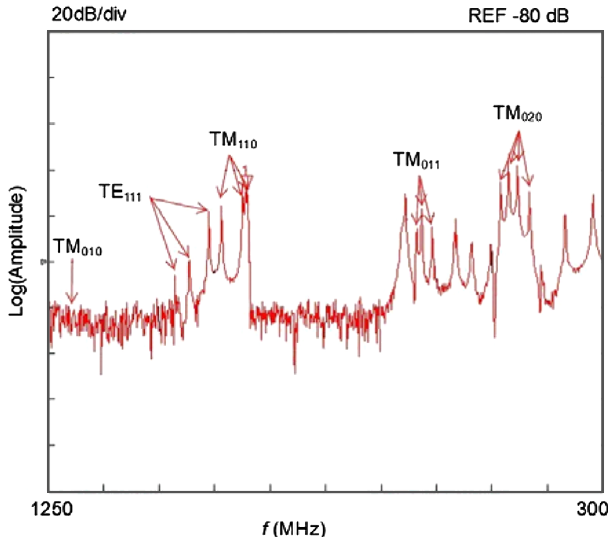
FIG. 6. (Color) Properties of HOM couplers of the 3.5-cell cavity. TM 010 mode is cut off and the HOMs can be extracted